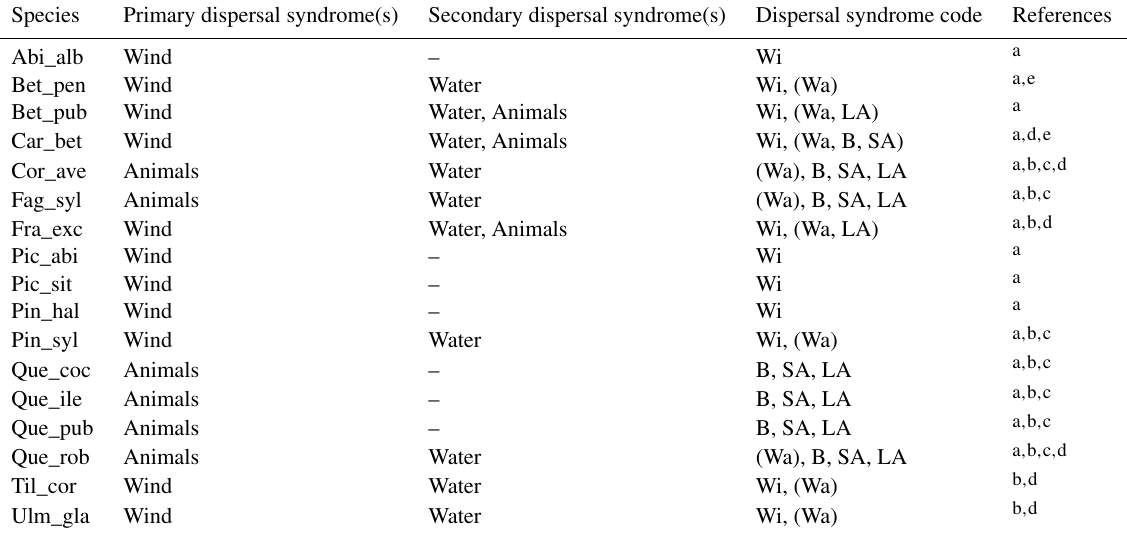
We classified a dispersal syndrome as a secondary mechanism in case its percentage of occurrence was < 30% with respect to other dispersal syndromes, with further support by research papers: a Vittoz and Engler (2007). b Wilkinson (1997). c Giannakos (1997). d Che´cko et al. (2015). e Lovas-Kiss et al. (2018). We excluded mechanisms which accounted for < 5% of dispersal